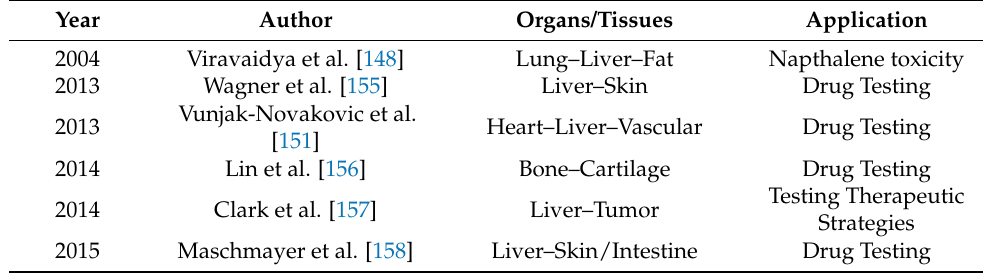
Figure 6. ( a ) The first example of a multi-organ tissue chip designed by Viravaidya et al. to recreate interactions between the liver, adipose tissue, and the lung to probe naphthalene toxicity. Reproduced with permission from John Wiley and Sons [148]; ( b ) A complex four-organ tissue chip developed by Maschmeyer et al. where interactions between the intestine (1), liver (2), skin (3), and kidney (4) were recreated, and circulatory and excretory circuits established. Reproduced with permission from the Royal Chemical Society [154]. Table 1. Microphysiological Systems.